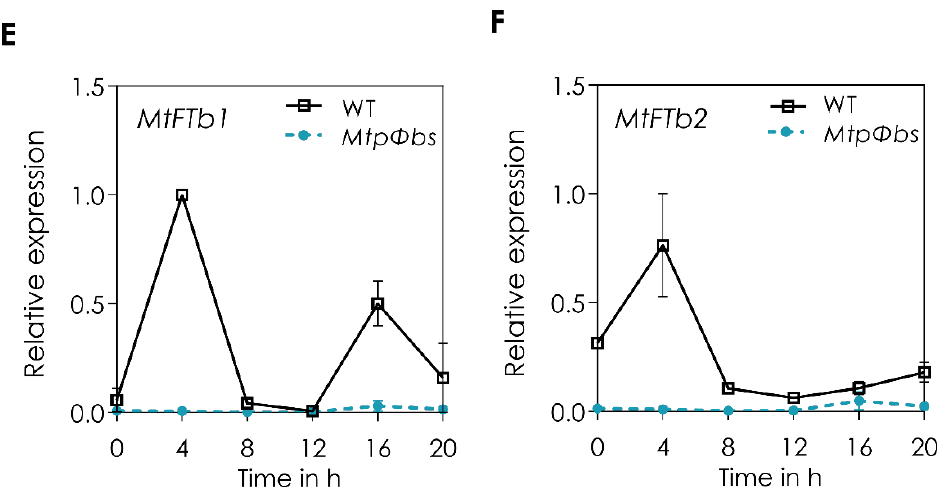
Figure 4. The legume-specific flowering gene, MtE1 , is downregulated in the Mtpφbs mutant. ( A ) Response to changes in photoperiod. WT R108 leaves were collected at ZT4 of plants grown in LD and SD conditions. Plants grown in SD were then transferred to LD conditions for 1, 2, and 3 days before being transferred again to SD for 3 more days. MtE1 gene expression in ( B ) MtpΦbs and MtphyA mutant, and respective WT. Relative transcript abundance was measured 4h after dawn in LD conditions. Diurnal expression profiles of ( C ) MtFTa1 , ( D ) MtE1 , ( E ) MtFTb1 and ( F ) MtFTb2 . Plants were entrained for 21 days under LD conditions. Tissues were harvested every 4h for a 24h period. Relative gene expression was measured by qRT-PCR with normalization to MtPDF2 . Data are the mean ± SEM and relative to the highest WT value. SD = short day (8h light/16h dark), LD = long-day (16 h light/8 h dark). ** p < 0.01, * p < 0.05 (Student t -test).